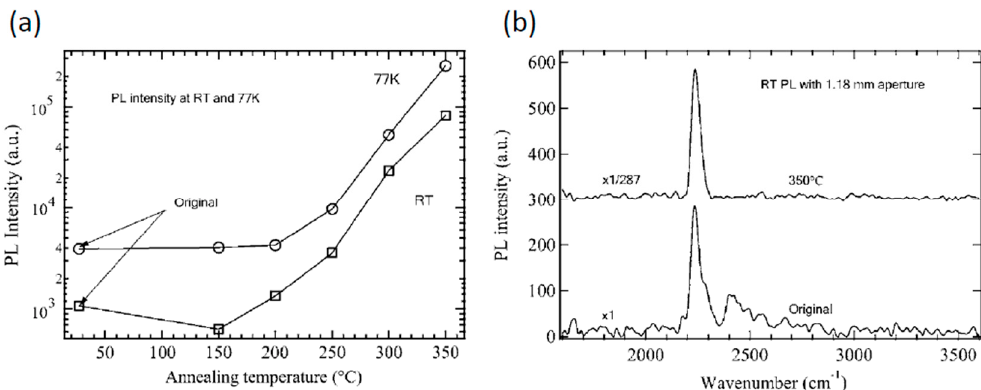
Figure 4. The defect passivation effect on the PbSe thin films fabricated by molecular beam epitaxy (MBE), ( a ) photoluminescence (PL) intensities versus annealing temperature at room temperature and 77 K, ( b ) a comparison of PL intensities of PbSe thin films treated at 350 °C and an as-grown one at room temperature. Reprinted with permission from [67]. Copyright AIP 2008.